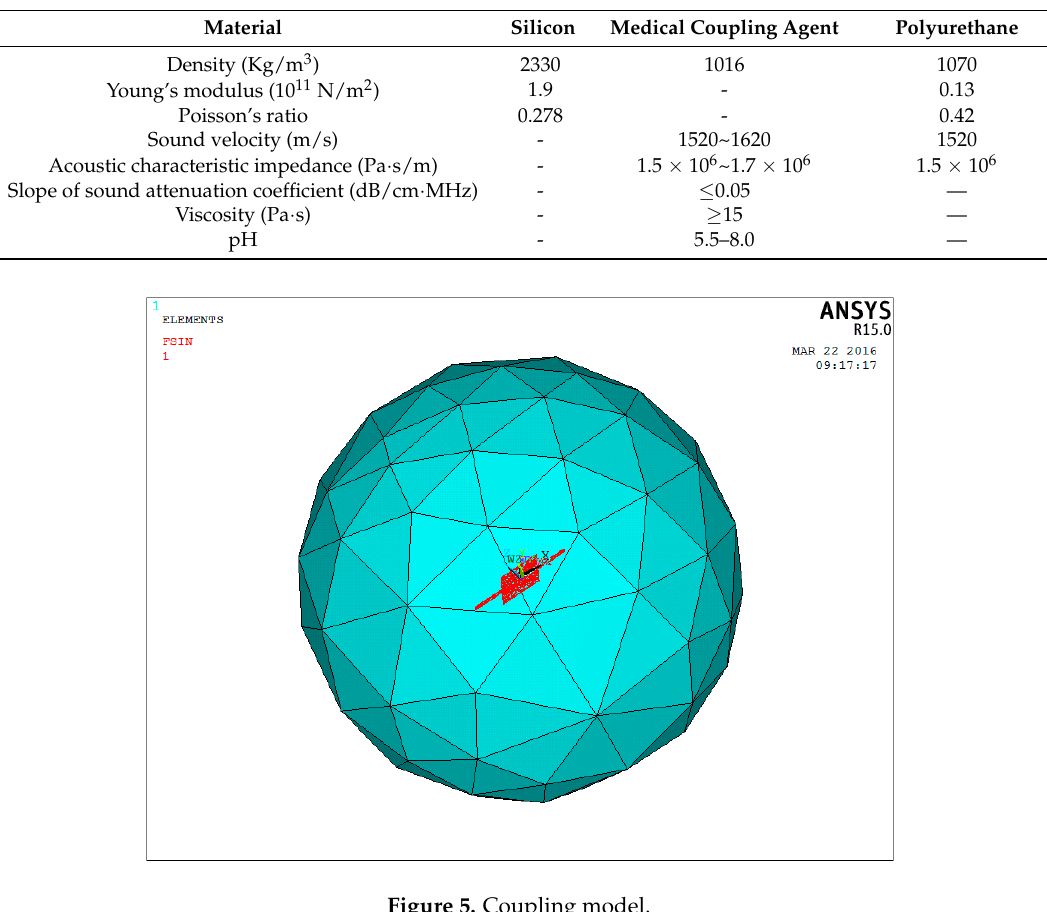
Sensors 2016 , 16 , 1728